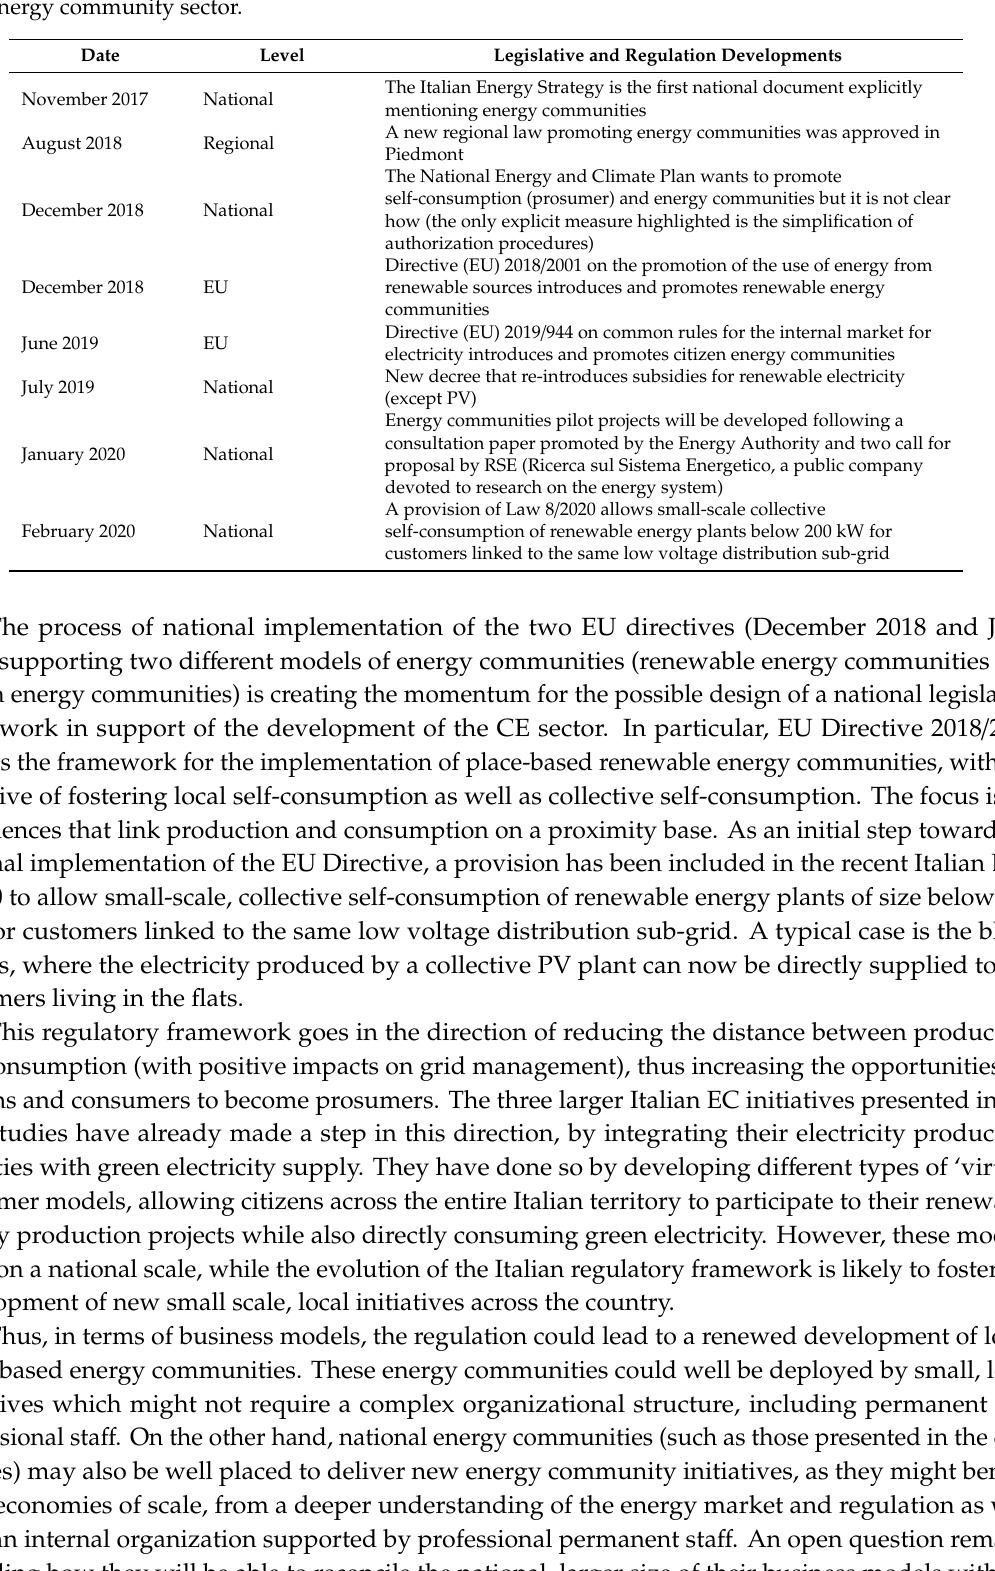
Table 8. Summary of recent legislative and regulation developments having an impact on the Italian energy community